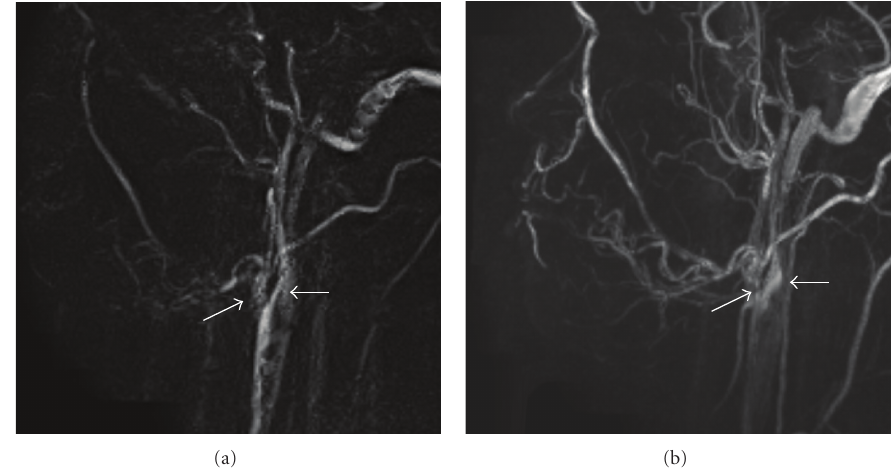
Figure 2: MRA using 2D-PC (a) and 3D-PC (b) in the oral and maxillofacial regions of a healthy 28-year-old volunteer. Three-dimensional (3D) PC-MRA has a better signal-to-noise ratio (SNR) and a better spatial resolution than 2D PC-MRA. (a) On MRA using 2D-PC, mainly the external (arrow) and internal carotid arteries (black arrow) and their branches are shown, but the image quality is low. Acquisition time was 9 minutes and 36 seconds. (b) On MRA using 3D-PC, the external (arrow) and internal carotid (black arrow) and many other branches are seen. The images are higher in quality in the same subject as in Figure 2(a). Acquisition time was 10 minutes and 15